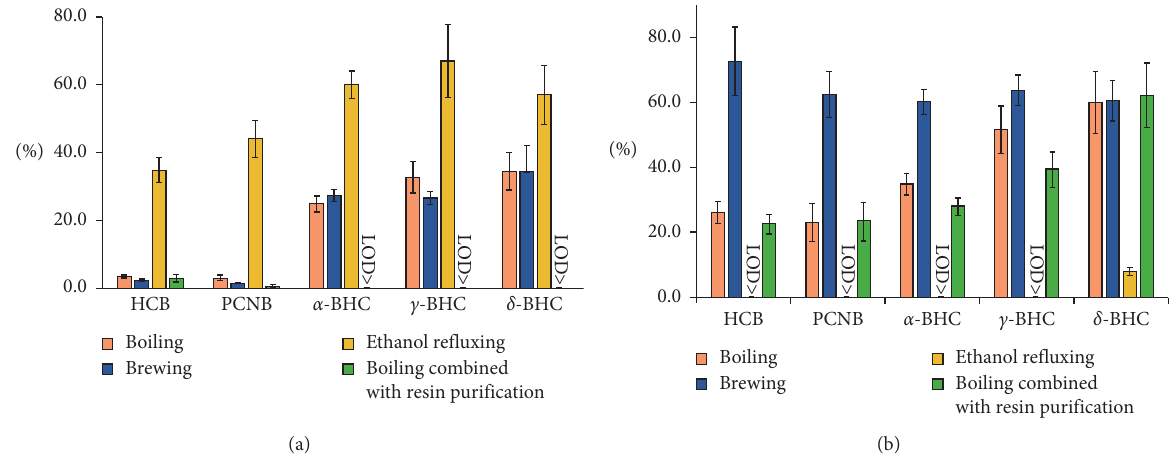
Figure 4: Transfer rates of (a) pesticides from raw ginseng to ginseng products and (b) the remaining of pesticides in ginseng dregs during household processing (boiling and brewing) and industrial processing (ethanol refluxing and boiling combined with resin purification). The error bars represent the standard deviation of measurements for three